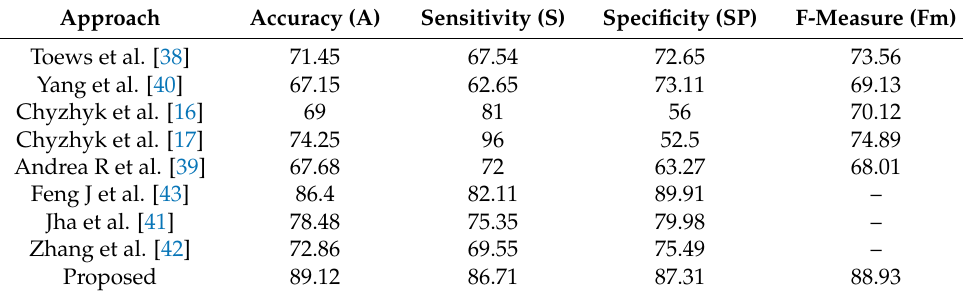
Table 3. Comparative analysis of proposed and state-of-the art